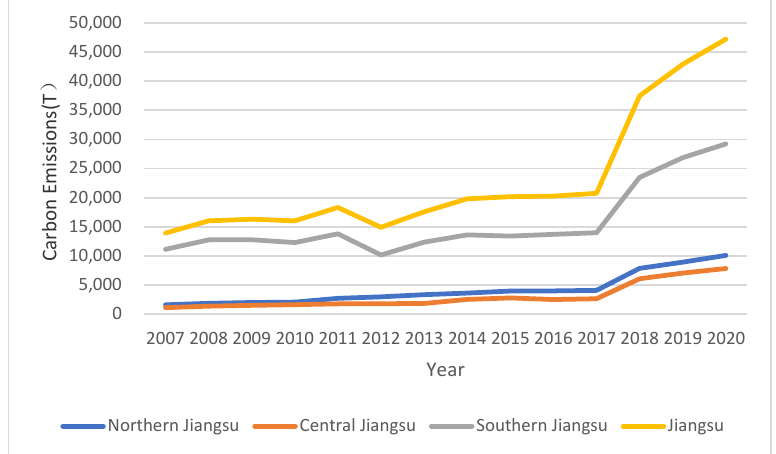
Figure 1. Carbon emissions in Jiangsu from 2007 to 2020.